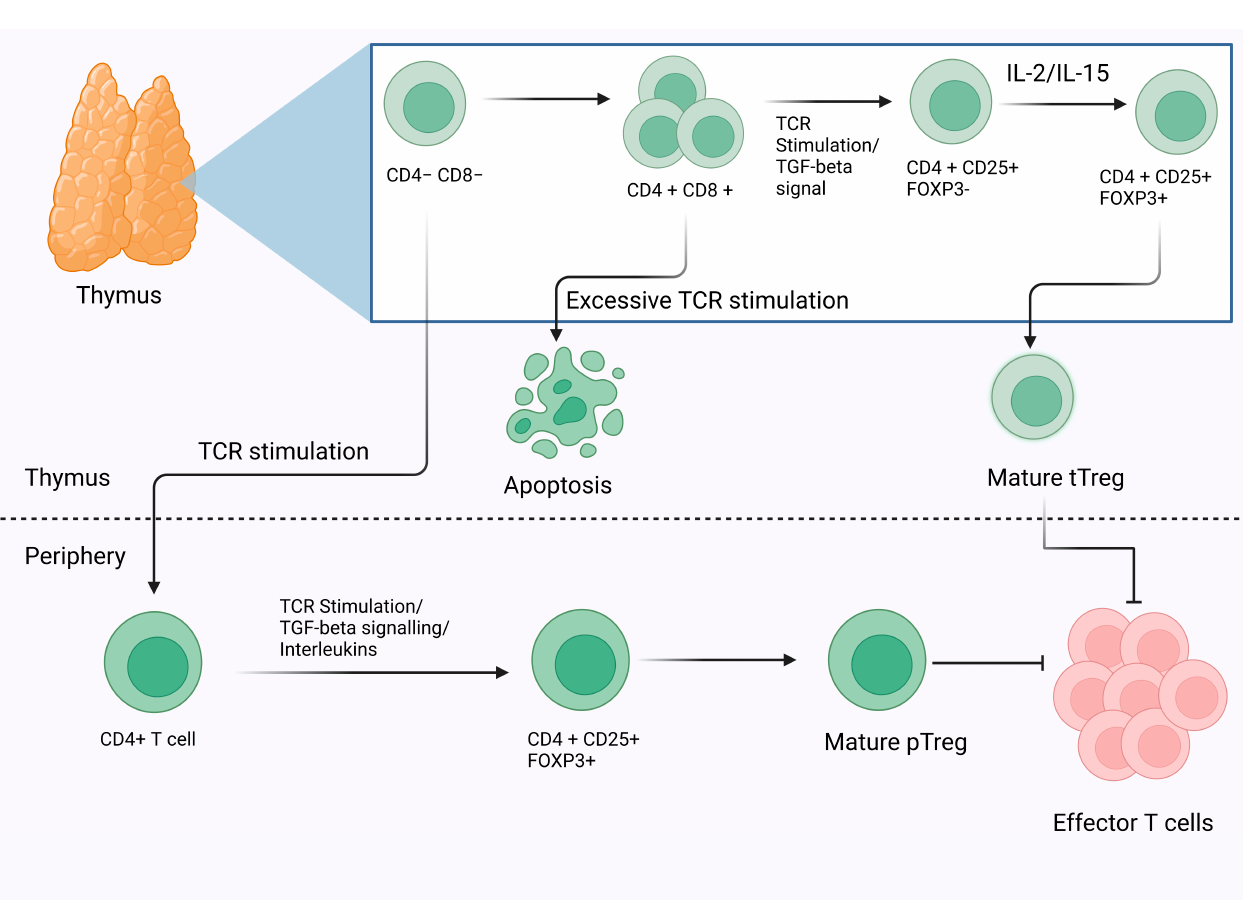
Figure 1. The schematic representation of the morphogenesis and development of Tregs. On the basis of the development and their functional markers, Tregs have been classified into two major categories thymic Tregs (tTregs) and peripheral Tregs (pTregs). Additionally, mature CD4+ Th cells can be induced into Tregs by TCR stimulation.